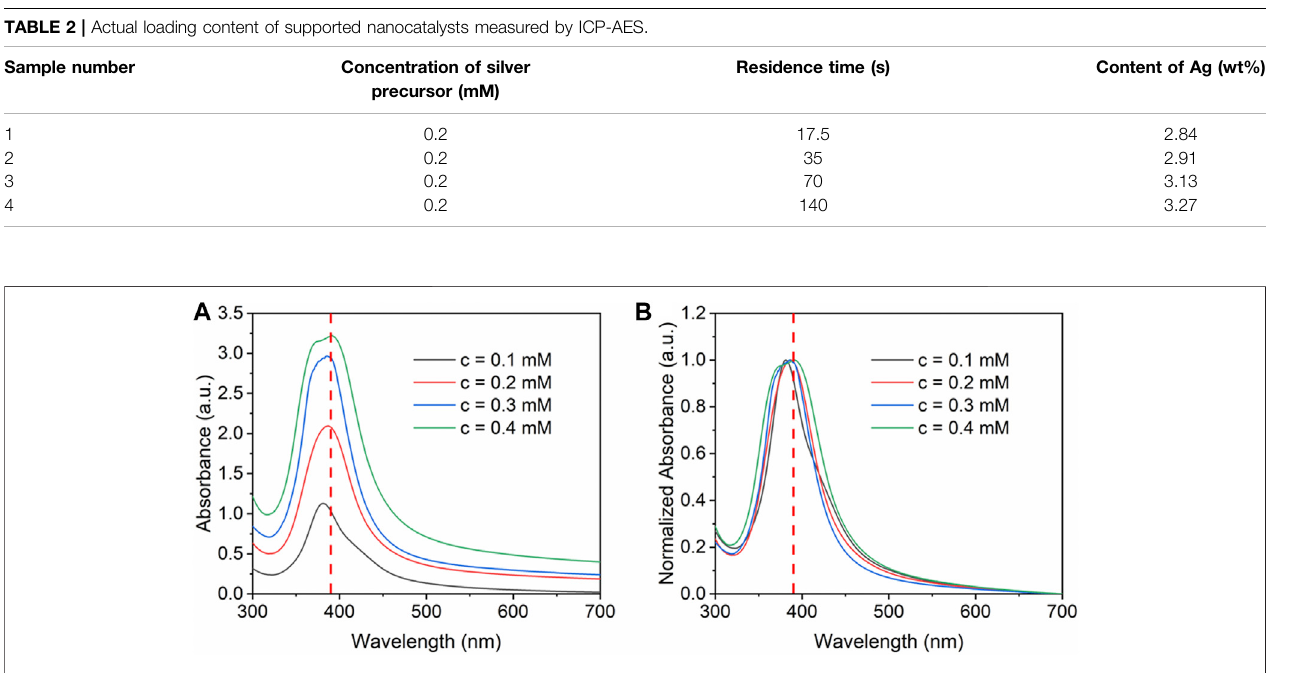
FIGURE 6 | (A) UV-vis absorbance spectra and (B) normalized absorbance spectra for Ag/SBA-15 synthesized at different concentration.